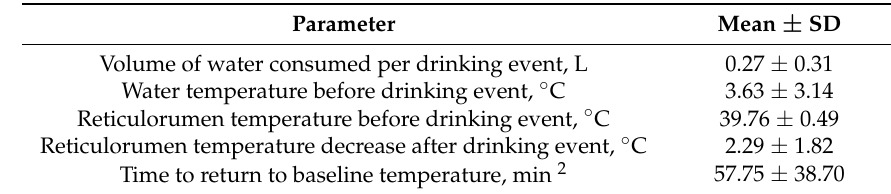
Table 2. Descriptive statistics for a consecutive 48-h observational study of 84 drinking events from 4 lactating, tie-stall housed Holstein cows with ad libitum feed and water access 1,2,3